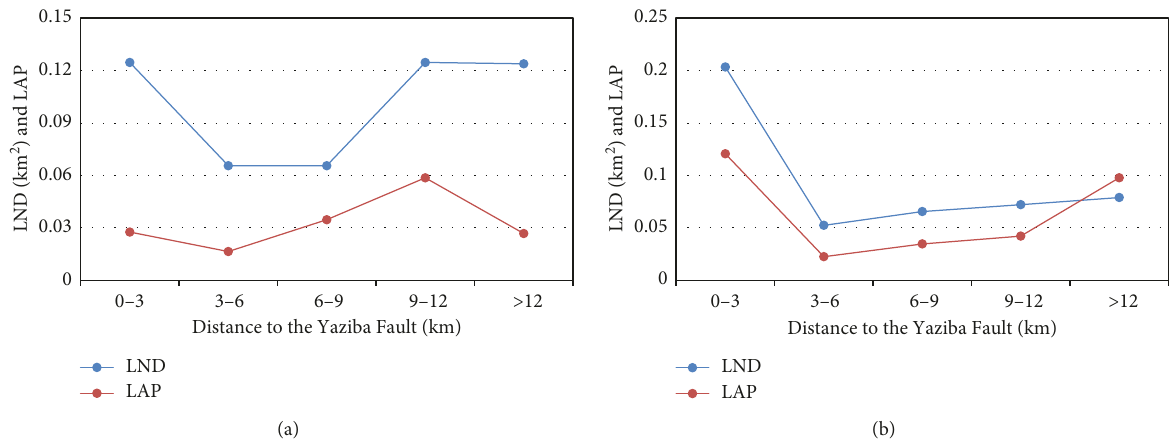
Figure 9: LND and LAP of different zones, i.e., different distances from the Yaziba Fault. (a) Left side of the fault, and (b) right side of the fault.